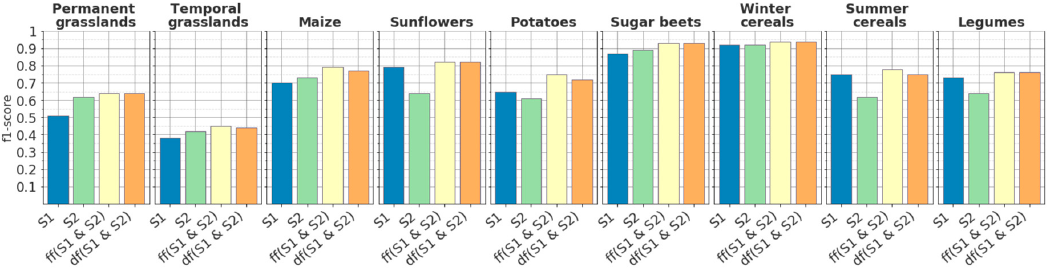
Figure 10. Grouped crop-specific accuracies derived from the classifications based on only SAR ( S1 ) features, only optical ( S2 ) features, their combination ( ff(S1&S2) ), and decision fusion df(S1&S2) .